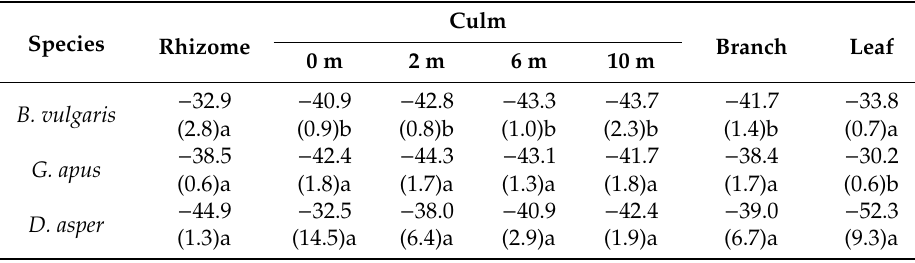
Table 3. Deuterium signature ( δ D, % (cid:24) ) in di ff erent organs of four B. vulgaris and three D. asper and G. apus where culms had been labeled 40 days earlier: signature in rhizomes, from di ff erent culm lengths, and from branches and leaves. The bamboos were cut down for the experiment. Means and standard errors. For each species, the di ff erent lowercase letters behind δ D values indicate significant di ff erence among